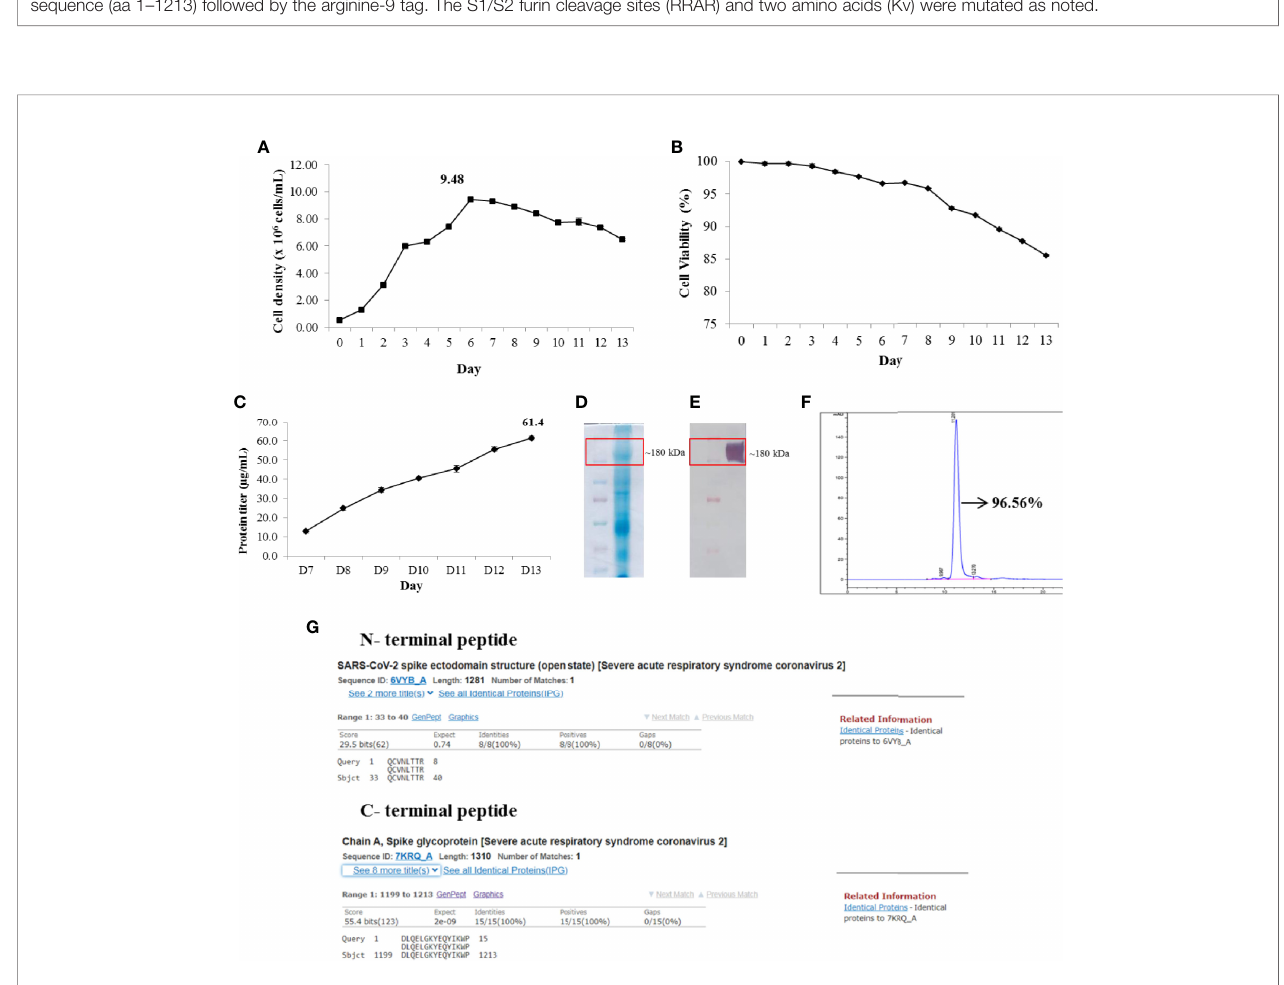
FIGURE 2 | High-yield production and characterization of recombinant SARS-CoV-2 spike (S) protein. Viable cell density (A) . Viability of cells (B) . Protein titer from day 7 to end of fed-batch culture (C) . Sodium dodecyl sulfate – polyacrylamide gel electrophoresis (SDS-PAGE) of harvest sample (D) . Western blotting of harvest sample (E) . Purity of S protein (F) . N- and C-terminal peptide sequencing and blasting to complete non-redundant database of protein sequence storage at the National Center for Biotechnology Information (NCBI) (G)